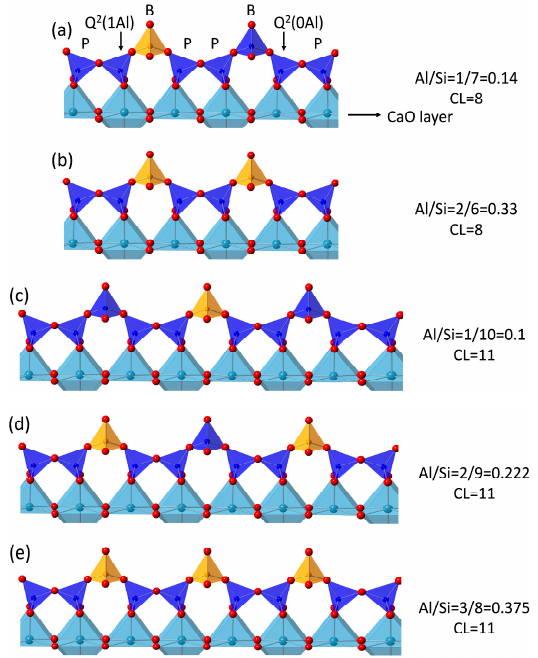
Figure 14. Schematics of the chain structure of Al substituted C–S–H with different chain lengths and Al/Si in the HVFA system. The silicate units are displayed as dark blue tetrahedrons, whereas the calcium and oxygen atoms are illustrated as light blue and red spheres, respectively.